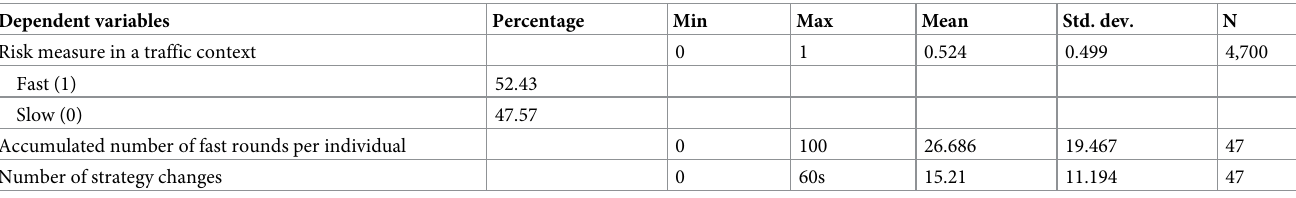
Table 1. Description of dependent